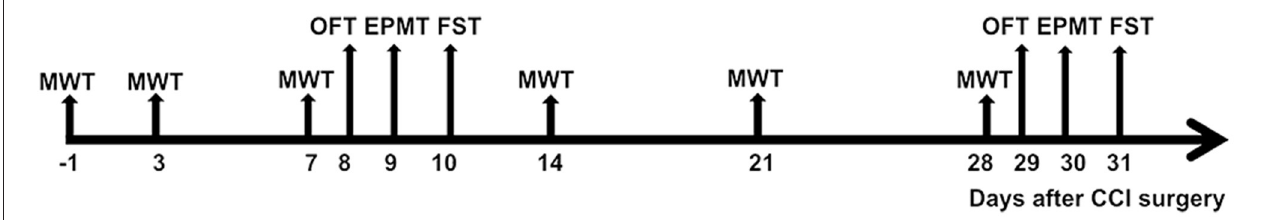
FIGURE 1 | Schematic of the experimental